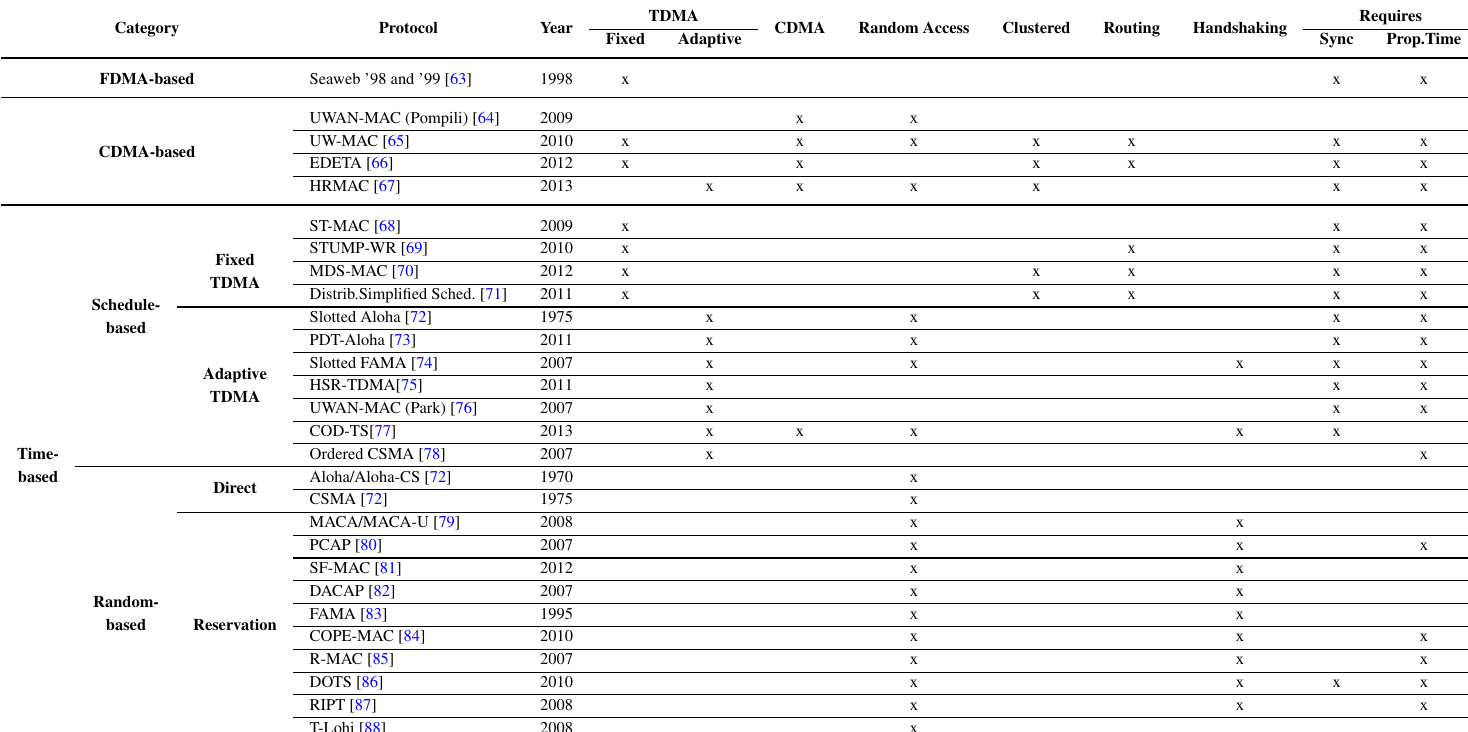
Table 3. Protocol classification and properties. TDMA, time-division multiple access; CDMA, code-division multiple access; FDMA, frequency-division multiple access; UW, under water; HRMAC, hybrid reservation-based MAC protocol; ST-MAC, spatial-temporal MAC; STUMP, staggered TDMA underwater MAC protocol; MDS, multi-dimensional scaling; FAMA, floor acquisition multiple access; COD-TS, cluster-based on-demand time sharing; CSMA, carrier sense multiple access; aloha-CS, aloha with carrier sensing; MACA, multiple access collision avoidance; PCAP, propagation-delay-tolerant collision avoidance protocol; SF-MAC, Spatially fair MAC; DACAP, distance-aware collision avoidance protocol; COPE-MAC, contention-based parallel reservation MAC; R-MAC, reservation-based MA; DOTS, delay-aware opportunistic transmission scheduling; RIPT, receiver-initiated packet train; T-Lohi,